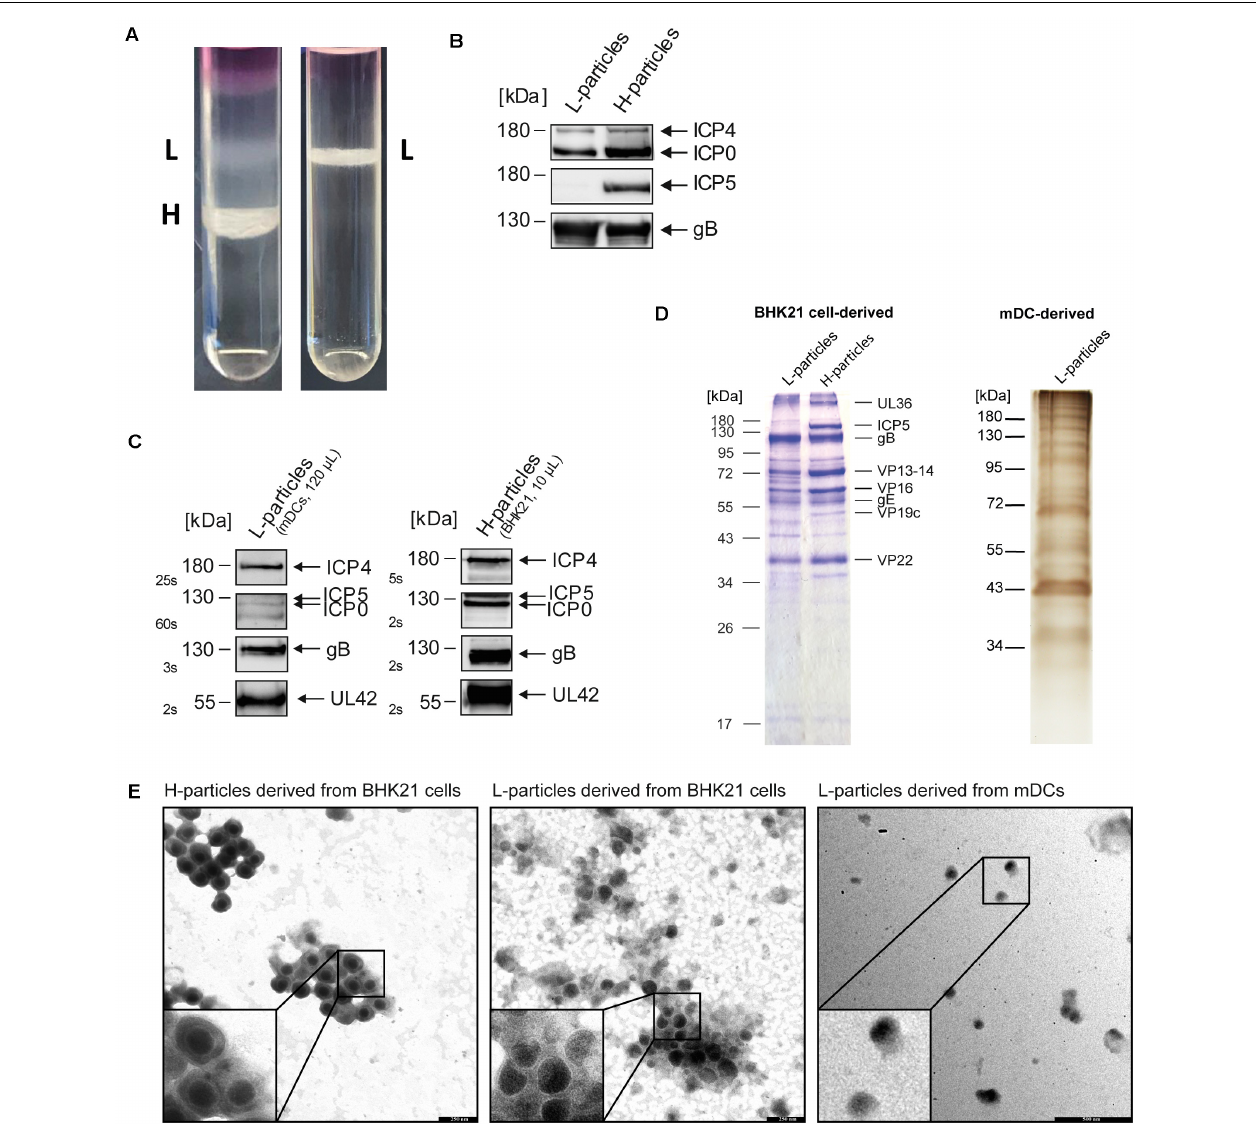
FIGURE 1 | Purification of L- and H-particles derived from HSV-1-infected BHK21 cells or mDCs. L-particles and H-particles were purified from supernatants of HSV-1-infected BHK21 cells and mDCs four days post infection and 20 hpi, respectively. (A) Representative Ficoll gradients from HSV-1-infected BHK21 cells (left panel) and mDCs (right panel) are shown. (B) Western blot analyses of L- and H-particle protein lysates derived from BHK21 cells. A total protein amount of approximately 4 µ g was loaded onto a 10% SDS gel. (C) Western blot analyses of L-particle protein lysates derived from HSV-1-infected mDCs (left panel) in comparison to BHK21 cell-derived H-particles (right panel). (B,C) Purity of particle preparations was verified by detection of ICP5, ICP4, ICP0, and gB using specific antibodies. Exposure time for detection is depicted as seconds (s). (D) Coomassie blue staining of H- and L-particle samples isolated from HSV-1-infected BHK21 cells loaded onto a 10% SDS-PAA gel (left). Silver staining of L-particles derived from HSV-1-infected mDCs loaded onto a 10% SDS-PAA gel (right). (E) Electron microscopic analyses of HSV-1 particles derived from either BHK21 cells or mDCs. HSV-1 particles were adhered to carbon-coated grids and stained using